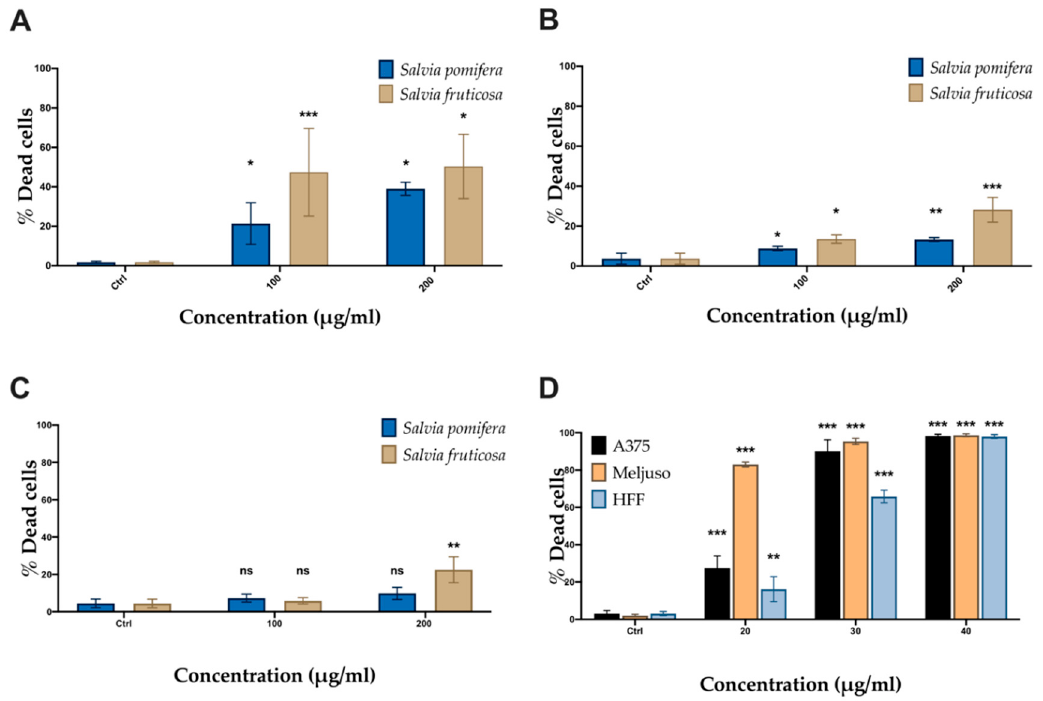
Figure 5. Antiproliferative activity of SF and SP extracts evaluated by PI-exclusion assay. ( A ) A375, ( B ) Mel JuSo, and ( C ) HFF cells were incubated with SP or SF extracts and ( D ) CA for 48 h. The data are the means ± S.E.M. of three independent experiments; * < 0.05, ** < 0.01 and *** < 0.001.